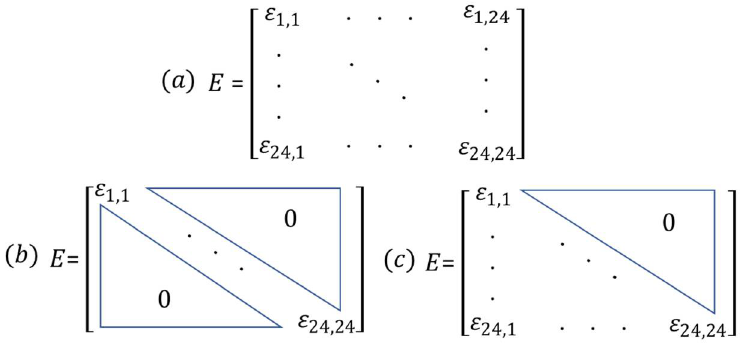
Figure 5. PEMD under different policies: ( a ) day-ahead DR, ( b , c ) hour-ahead DR.